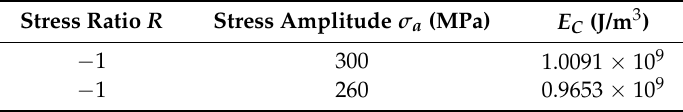
Table 4. Energy tolerance to failure E C under different stress amplitude.